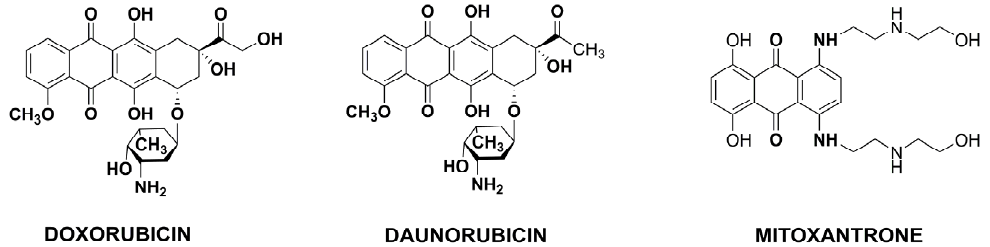
Figure 4. The selected structures of anticancer antibiotics.